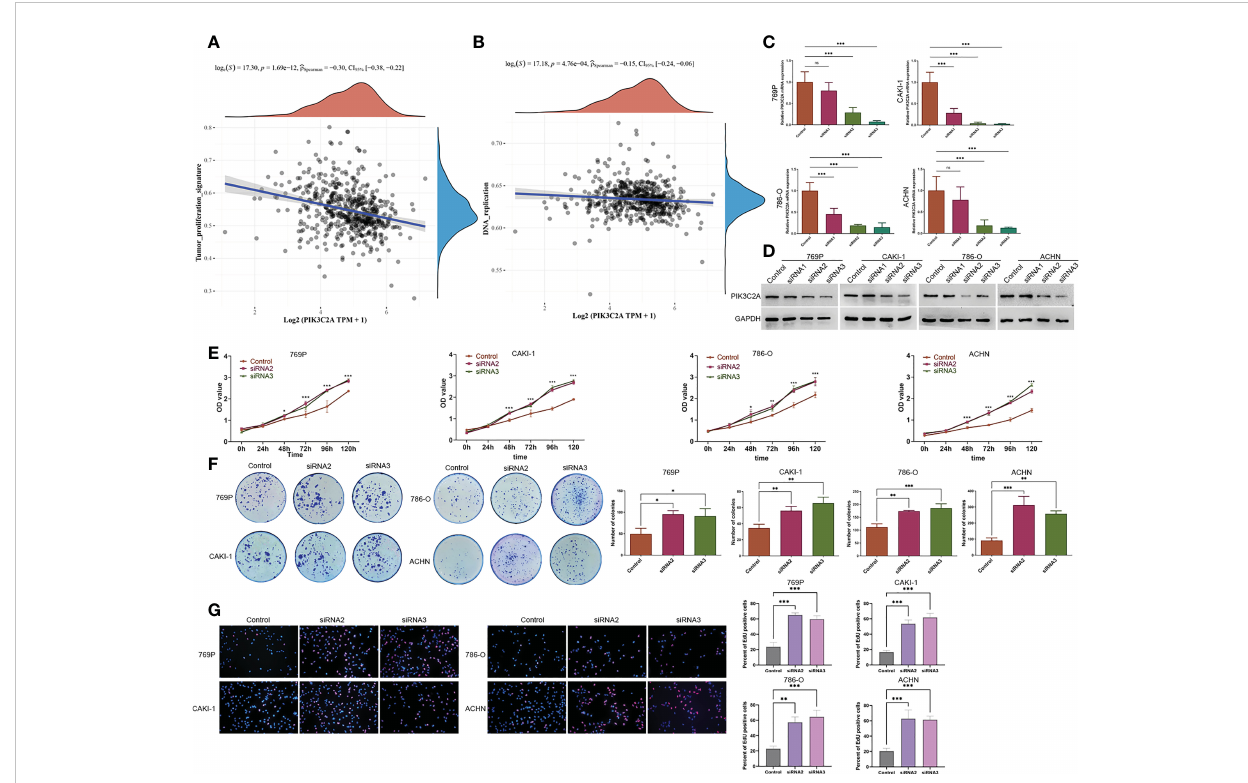
FIGURE 5 A decrease in PIK3C2A levels facilitated cell growth in KIRC cells. (A, B) The linear relationship of PIK3C2A expression with tumor proliferation signature and DNA replication pathway by Spearman ’ s correlation. (C, D) The levels of PIK3C2A mRNA and protein were signi fi cantly inhibited by siRNA2 and siRNA3. (E) CCK8 assay was used to detect cell proliferation in siRNA2- and siRNA3-transfected 769P,CAKI-1 786-O and ACHN cells. * P < 0.05, *** P < 0.001. (F) Using the colony-forming test, the colony-forming ability of 769P,CAKI-1 786-O and ACHN cells treated with siRNA2 and siRNA3 was evaluated. The number of colonies was counted and compared in the diagrams; signi fi cance was determined using one- way ANOVA. * P < 0.05, ** P < 0.01, *** P < 0.001. (G) EdU assays were performed to determine the cell proliferation ability of si-PIK3C2A transfected cells. The ratio of EdU-positive cells was calculated and compared in the diagrams; signi fi cance was determined using one-way ANOVA. ** P < 0.01, *** P < 0.001. ns, no signi fi